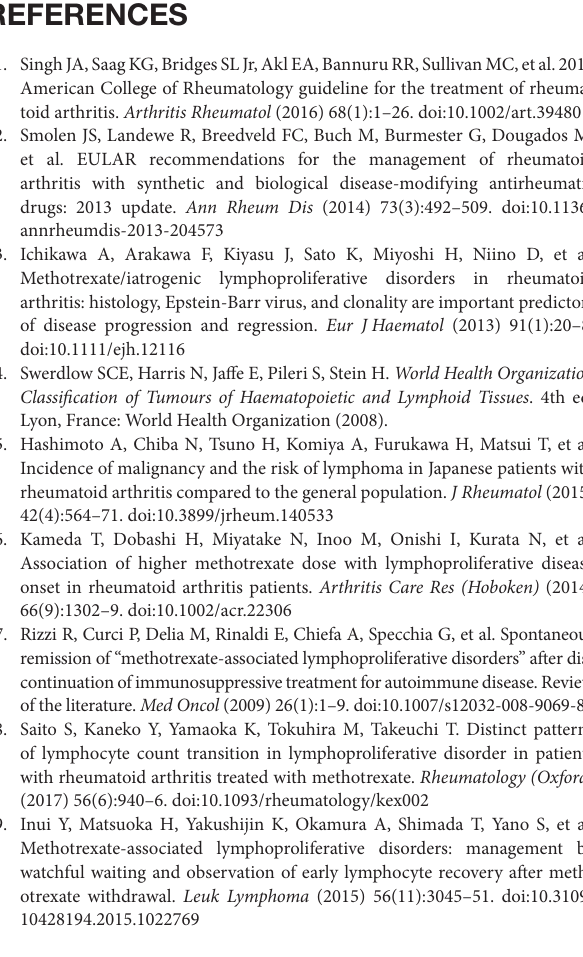
Figure s1 | Transition of Th1 cells and EMCD8 + T cells between different pathological classifications of lymphoproliferative disorders (LPDs). Transition of the proportion of Th1 cells among CD4 + T cells in (a) regressive LPD and (B) persistent LPDs, and transition of the proportion of EMCD8 + T cells among CD8 + T cells in (c) regressive LPD and (D) persistent LPDs. Th1, T helper 1; EM, effector memory. Figure s2 | Transition of quantitative Epstein–Barr virus (EBV)-PCR level after methotrexate (MTX) cessation and correlation between change of EBV-PCR and EBV-specific CD8 + T cells. (a) Transition of quantitative EBV-PCR level after MTX cessation and (B) correlation between change of EBV-PCR and EBV- specific CD8 + T